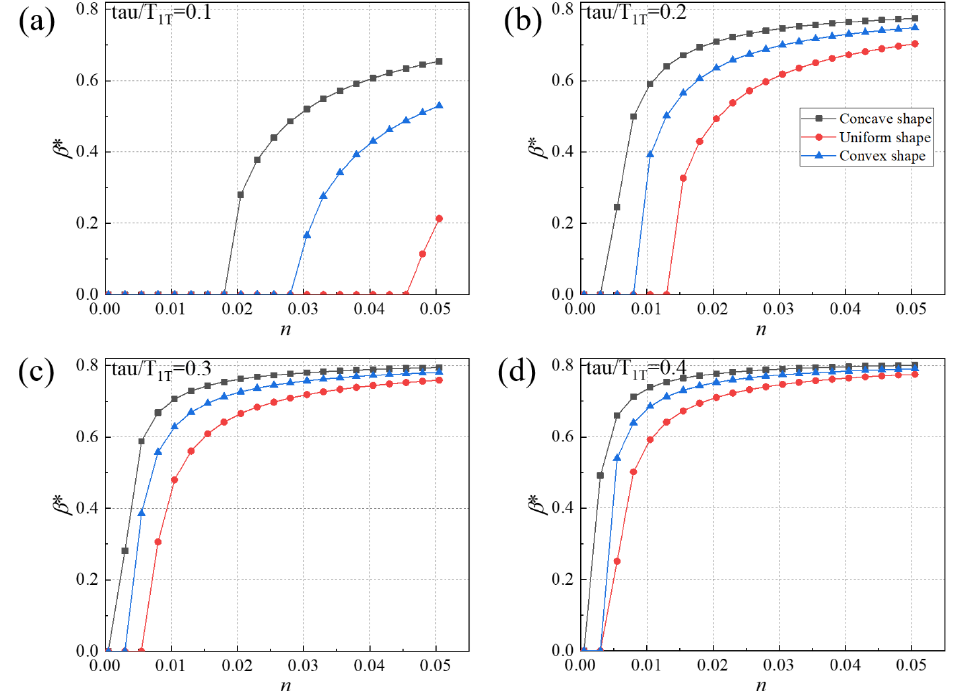
Figure 11. The bifurcation diagrams for three flame distribution shapes and different time delay τ . ( a ) τ / T 1T = 0.1; ( b ) τ / T 1T = 0.2; ( c ) τ / T 1T = 0.3; ( d ) τ / T 1T =